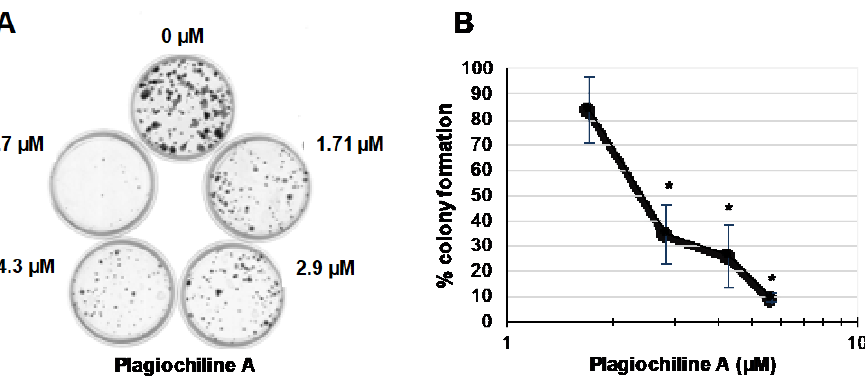
Figure 3. Plagiochiline A inhibits DU145 prostate cancer cell survival in clonogenic assays. DU145 cells were plated at low density in 60 mm plates and incubated in the presence of various concentrations of plagiochiline A, as indicated in the figure. After 15 days of incubation, cells were washed with cold phosphate-buffered saline (PBS), fixed with paraformaldehyde, and stained with crystal violet solution. ( A ) A photograph of one representative experiment is shown; ( B ) Graph showing number of colonies observed in plagiochiline A-treated samples as a % of colony number in control samples (treated with equivalent amount of DMSO vehicle). Data points represent the mean of three independent experiments ± standard error. Values indicated by * were significantly reduced compared to control cells without plagiochiline A ( P ≤ 0.006).